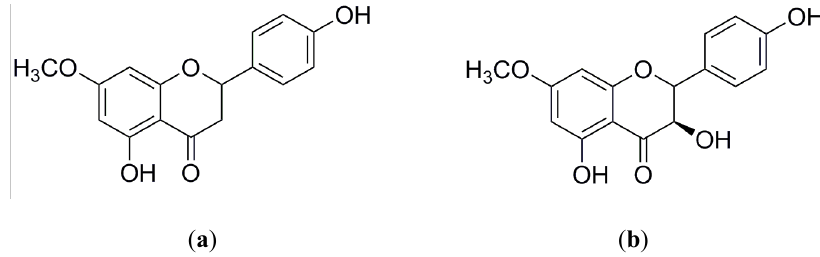
Figure 1. Chemical structures of: ( a ) sakuranetin; ( b ) 7-methoxyromadendrin.